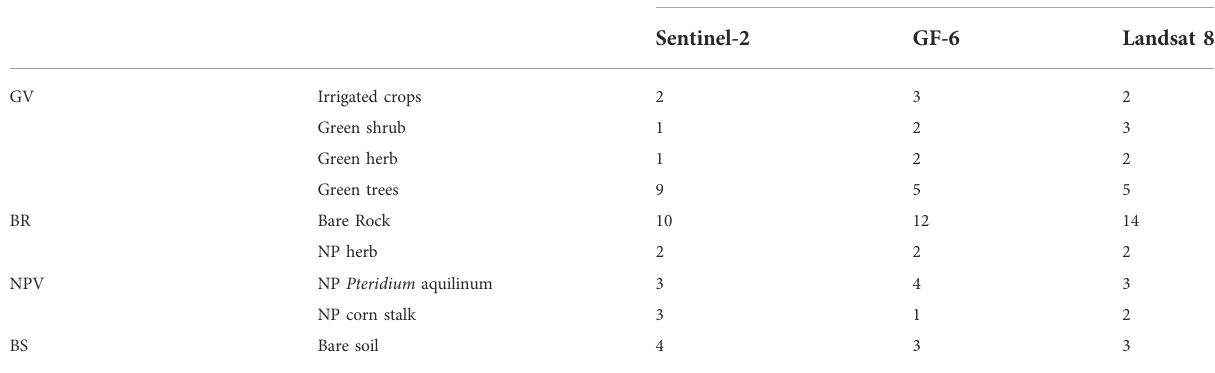
TABLE 1 Optimal endmembers libraries. Spectral